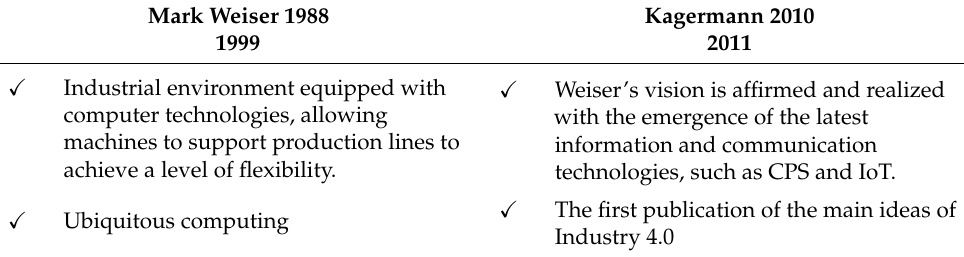
Table 5. The genesis of the